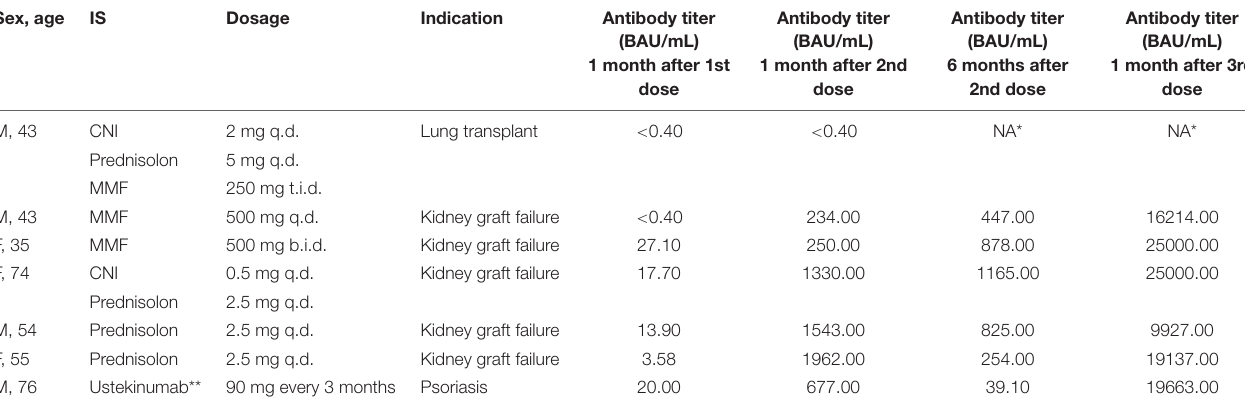
TABLE 2 | Antibody titers after mRNA-1273 vaccination in peritoneal dialysis patients with immunosuppressive therapy. Sex, age IS Dosage Indication Antibody titer